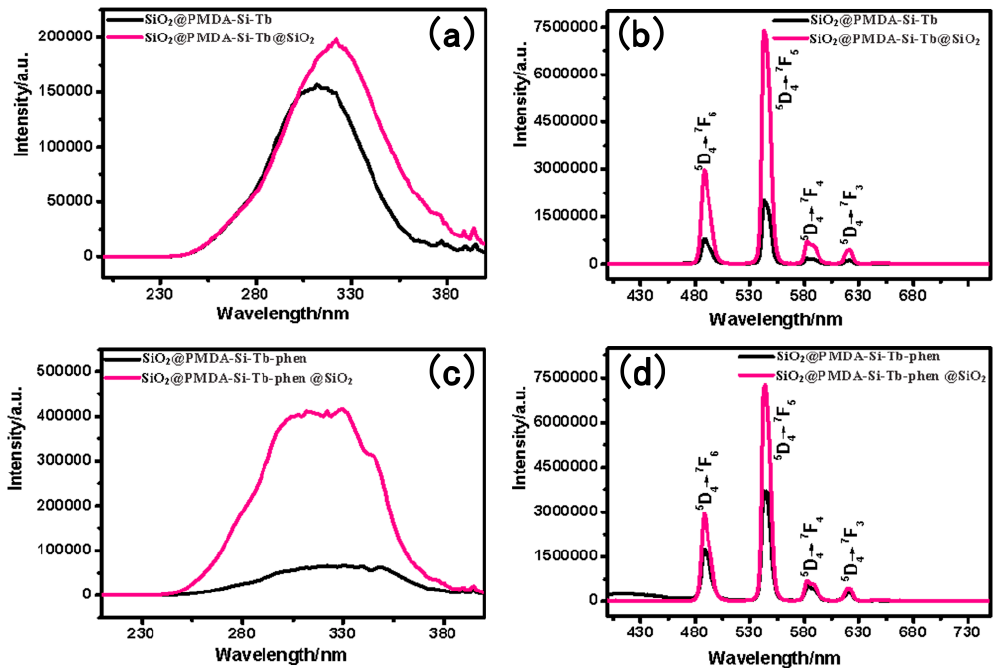
Figure 8. Fluorescent excitation spectra ( a , c ) and emission spectra ( b , d ) of Tb(III) core-shell and core-shell-shell composites (a, b: SiO 2 @PMDA-Si-Tb (black line) and SiO 2 @PMDA-Si-Tb@SiO 2 (pink line); c, d: SiO 2 @PMDA-Si-Tb-phen (black line) and SiO 2 @PMDA-Si-Tb-phen@SiO 2 (pink line)).